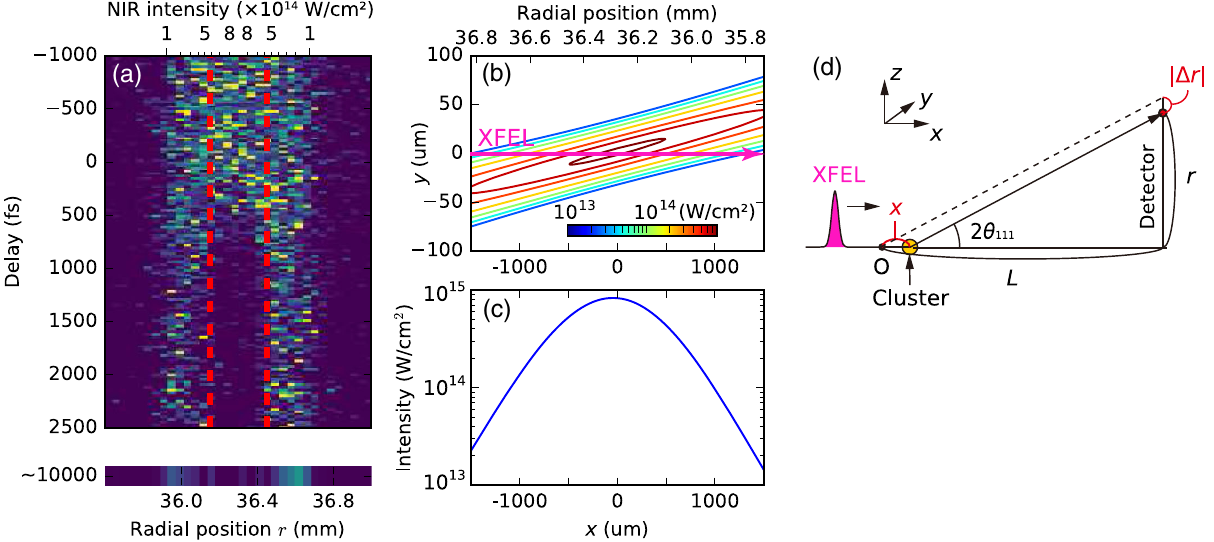
FIG. 2. (a) Delay-dependent radial profile of the diffraction intensities I ð r; t Þ around the f 111 g The upper axis indicates the estimated NIR intensity at the corresponding particle positions. (b) Top view of the spatial intensity distribution of the NIR laser in the interaction region. (c) NIR laser intensity distribution along the XFEL beam. (d) Schematic geometry of the diffraction